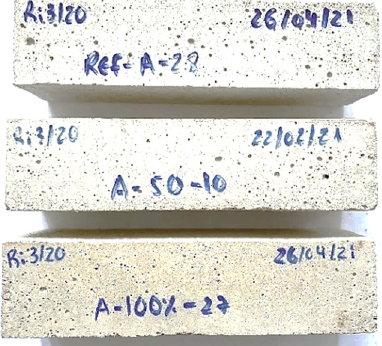
Figure 4. Mortars REF-A, A-50% and A-100% samples